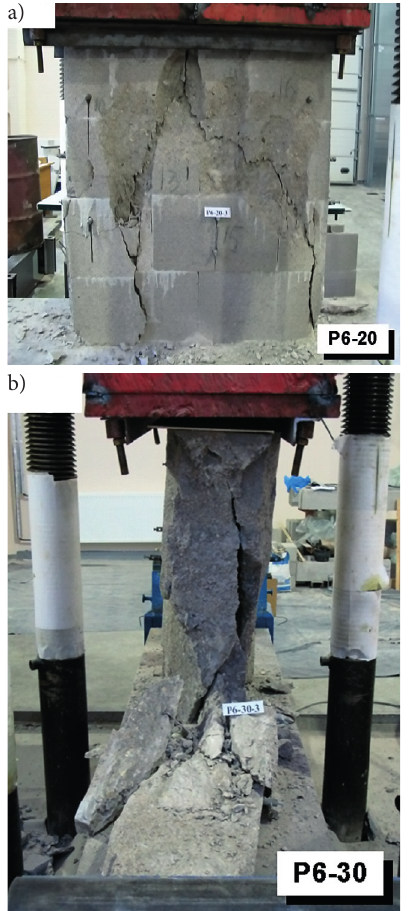
Fig. 7. Failure of P6-20 (a) and P6-30 (b) concrete blocks with concrete infill specimen of masonry